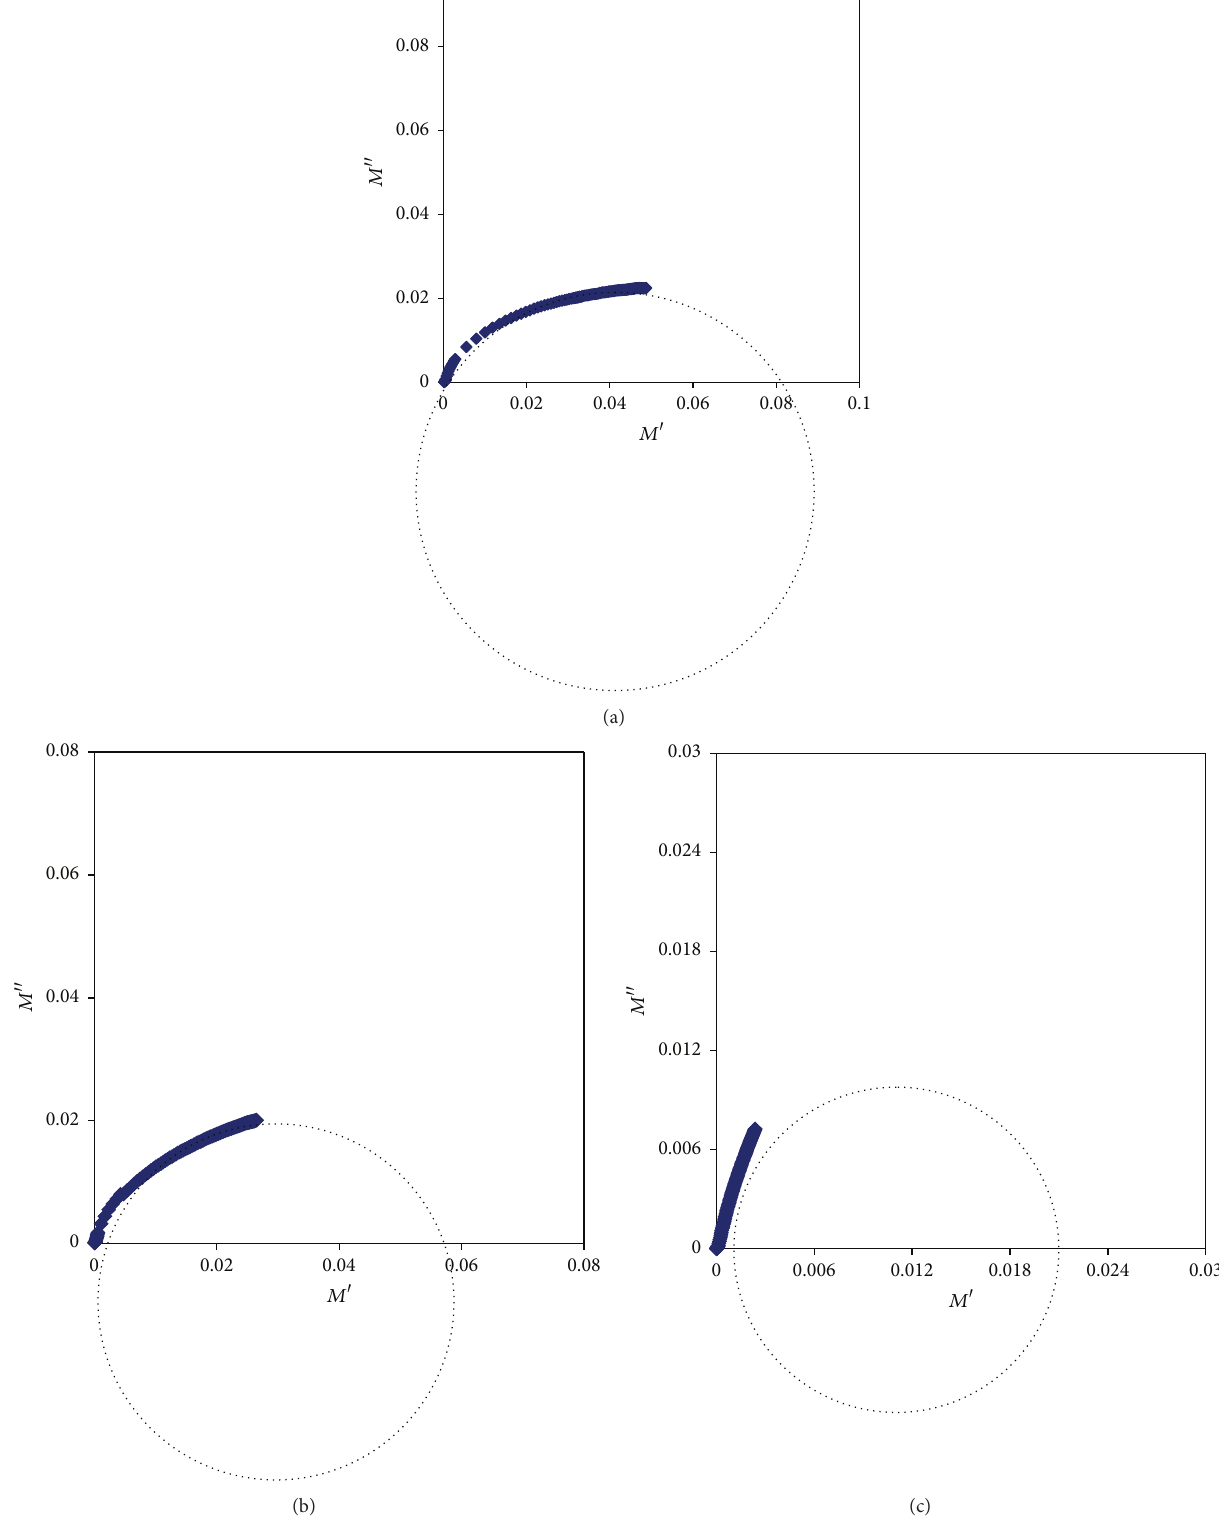
Figure 19: Argand plots for NCPE (CSNC2) at (a) 303 K, (b) 323 K, and (c) 343